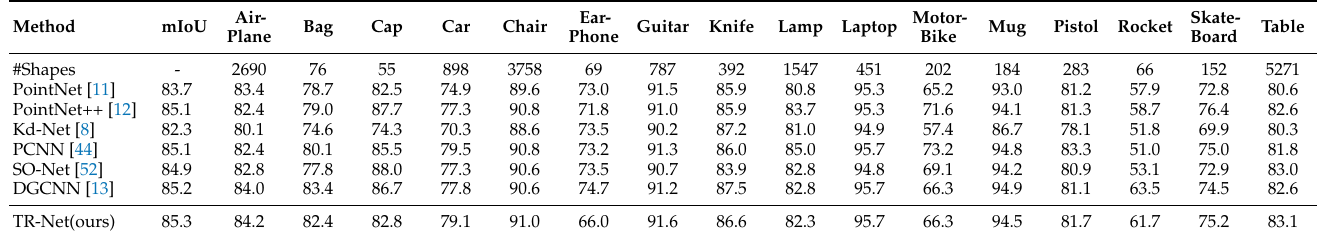
Table 5. Comparison on the ShapeNet part segmentation dataset.